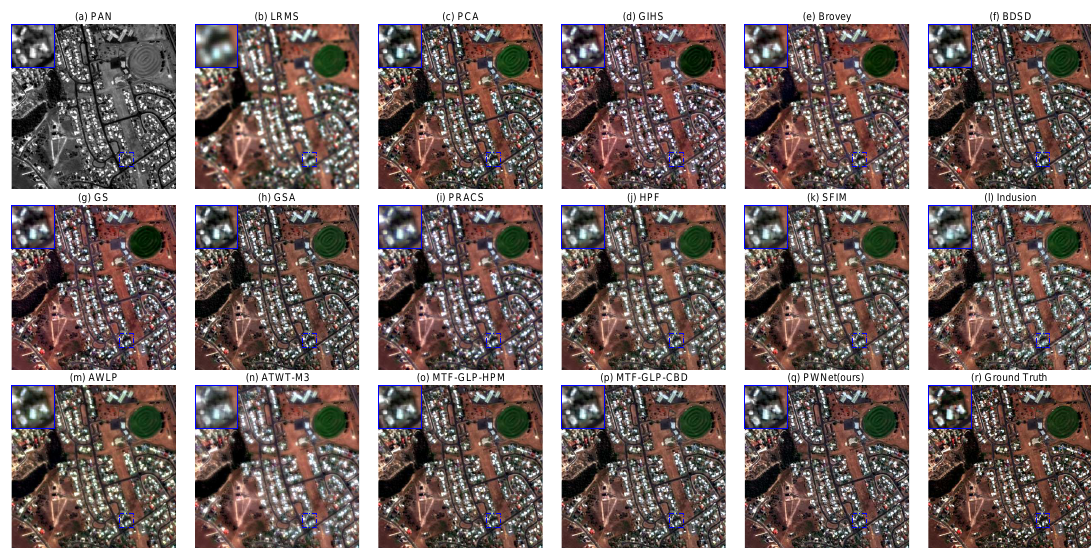
Figure 6. Visual comparison of the CS-based and MRA-based methods and the proposed PWNet method on the GeoEye-1 images, ( a ) PAN; ( b ) LRMS; ( c ) PCA; ( d ) GIHS; ( e ) Brovey; ( f ) BDSD; ( g ) GS; ( h ) GSA; ( i ) PRACS; ( j ) HPF; ( k ) SFIM; ( l ) Indusion; ( m ) AWLP; ( n ) ATWT-M3; ( o ) MTF-GLP-HPM; ( p ) MTF-GLP-CBD; ( q ) PWNet (ours); ( r ) Ground Truth.